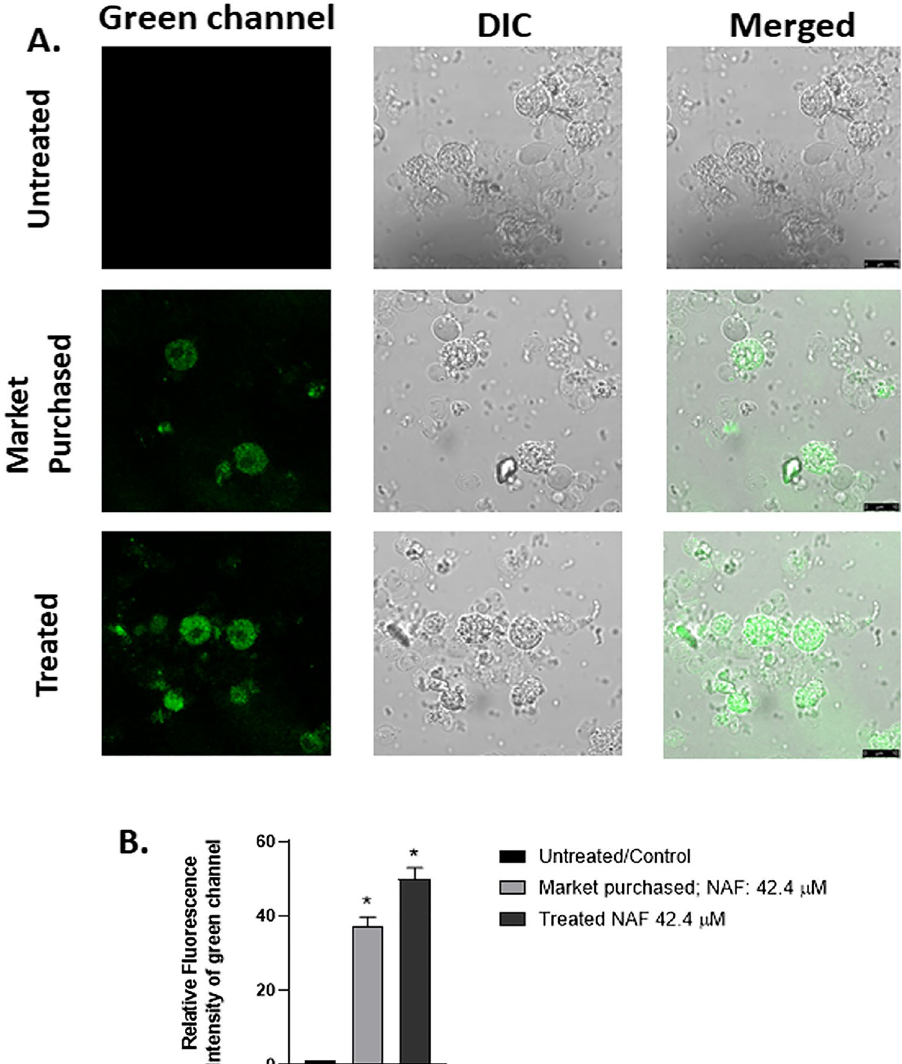
Figure 4. Confocal microscopic images of isolated hepatocytes from chicken ( A ) that were either left untreated (control) or treated with Colistin for 32 days (400 mg/day first 15 days, 600 mg/day for the rest of the treatment period) and the purchased one with 42.4 µM of NAF for 45 min. Green channel, DIC images and merged images untreated, purchased and treated cells are shown in consecutive rows. Scale bar is 10 μm. Zoom factor = 2.4. Magnification = ×630. ( B ) Relative fluorescence intensity of the above-mentioned images was quantified using ImageJ v 1.46 software and